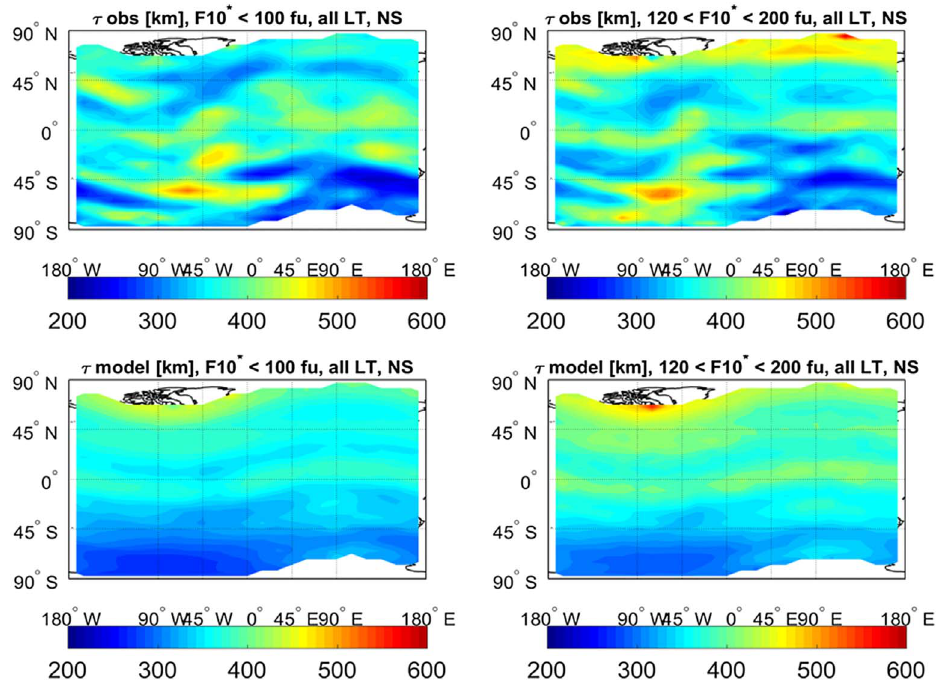
Fig. 5. Daily averaged global maps of observed and modelled s for LSA (left) and HSA (right) conditions for Northern summer